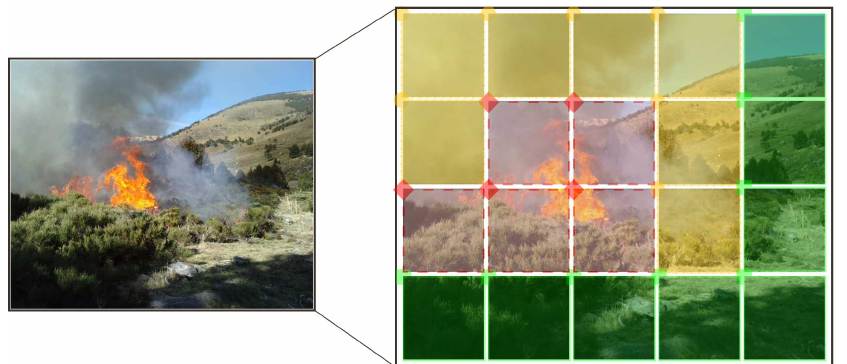
Figure 7. The process of image tessellation and labelling for multiclass classification is illustrated. Labeling of sub-images is shown in different colors in the upper left corner: (i) the image with a red diamond represents a sub-image with fire, (ii) the image with a green square represents a sub-image with no fire, and (iii) the image with a yellow circle represents a sub-image with smoke. (Best viewed in